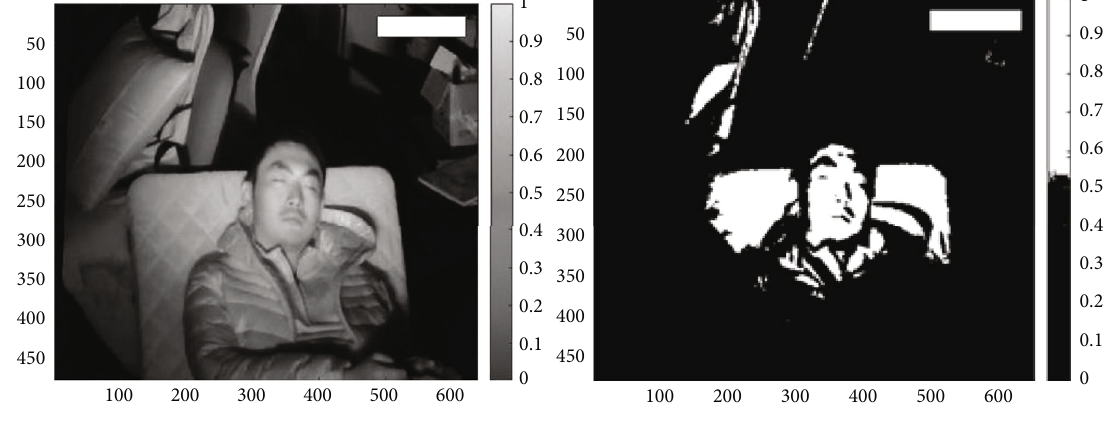
Figure 7: Threshold fi